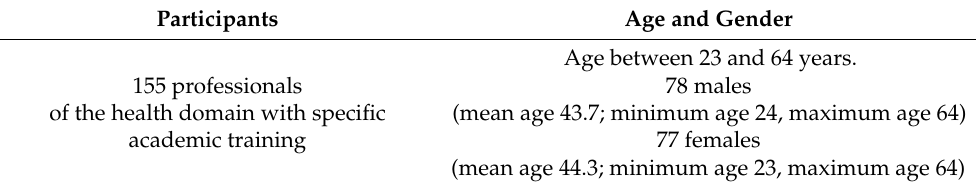
Table 1. Demographics characteristics.